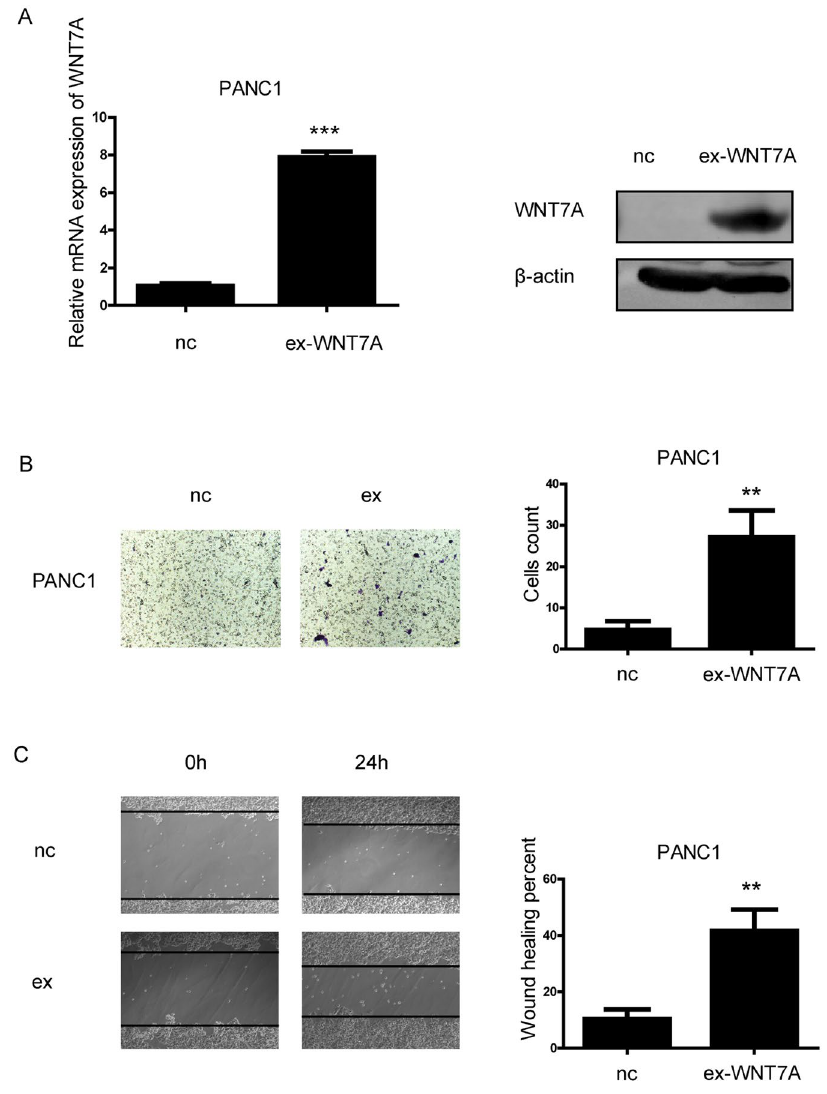
Figure 4. Over-expression of WNT7A promotes the migration capacity of pancreatic cancer cells in vitro . ( A ) The expression of WNT7A at mRNA and protein level were determined by qRT-PCR and Western blot respectively in cells transfected with negative control and wnt7a plasmid. ( B ) Impact of over-expression of WNT7A on PDAC cell’s migration capacity in transwells assays. ( C ) Impact of over-expression of WNT7A on PDAC cell in wound healing assays. ** P < 0.01, *** P <